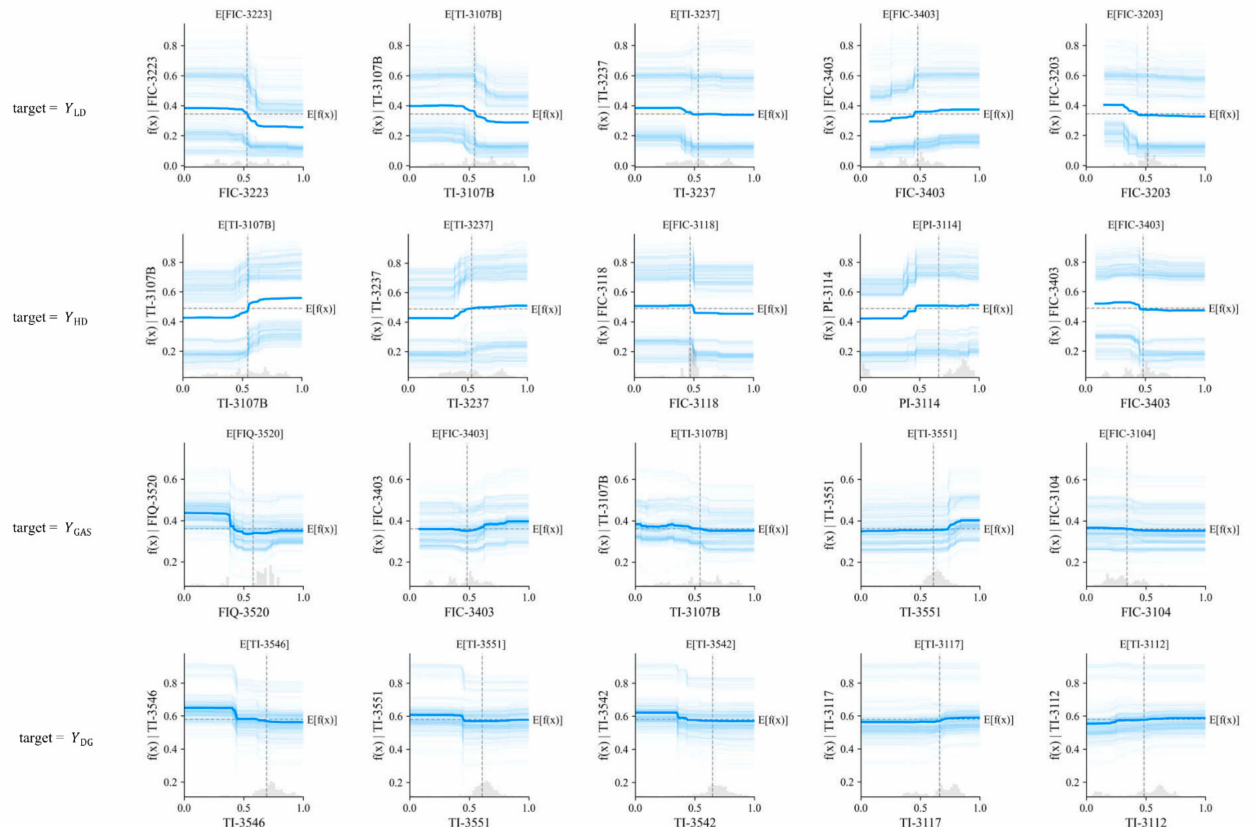
Figure 12. ICE and PDP plots between each target and the top five important variables identified by